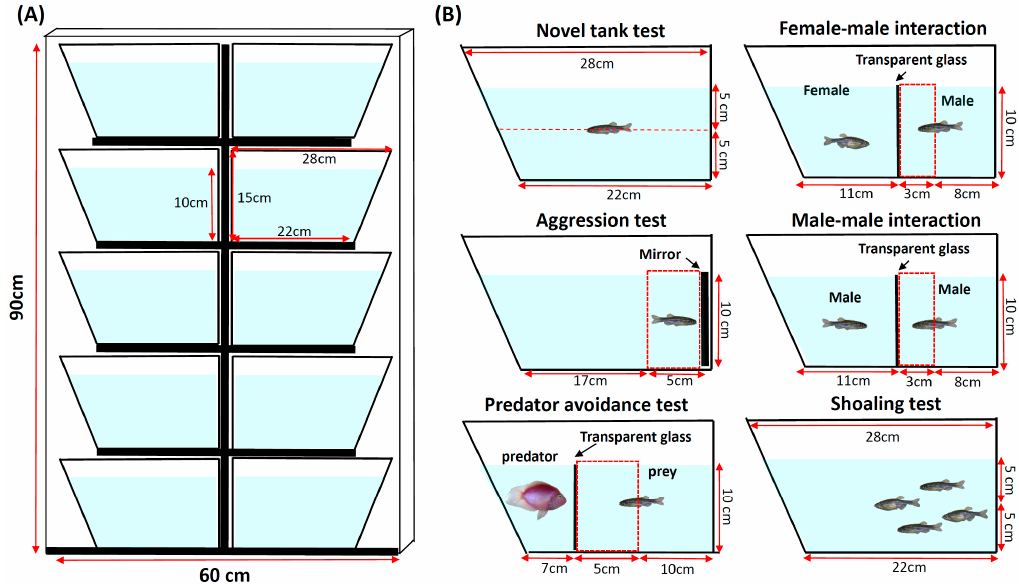
Figure 1. ( A ) The schematic picture for zebrafish tower setup. ( B ) The experimental setting of zebrafish tower for multiple behavior endpoints tests (Upper left corner: novel tank test, center left corner: aggression test, bottom left corner: predator avoidance test, upper right corner: female-male interaction, center right corner: male-male interaction, bottom right corner: shoaling test).